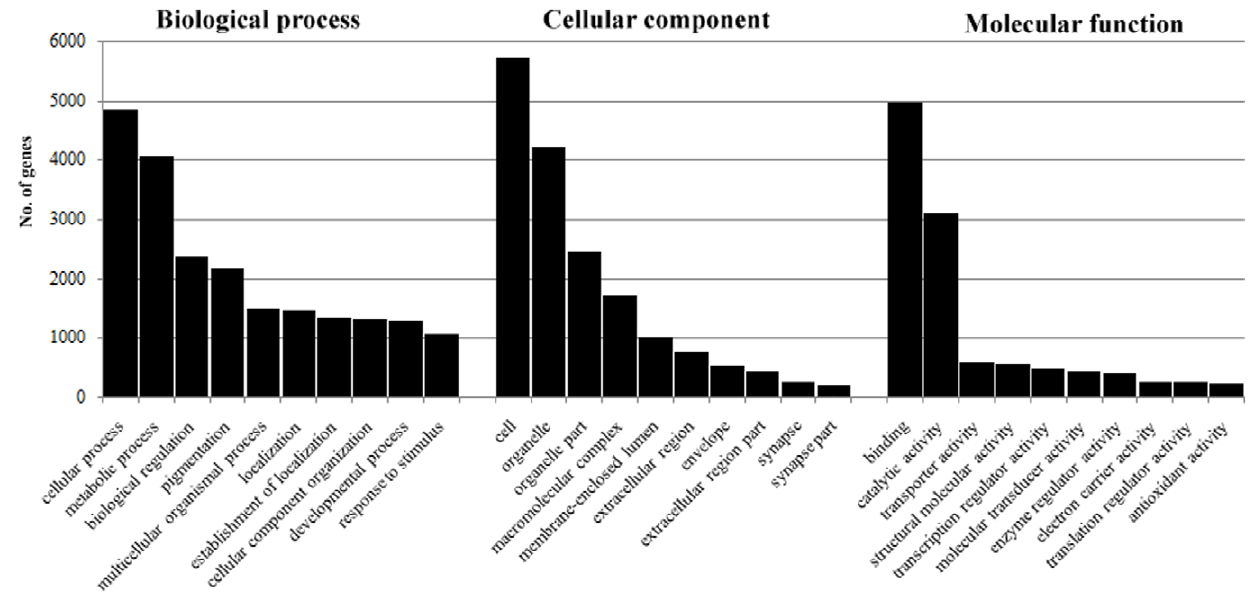
Figure 4. Gene ontology (GO) annotation of the H.diversicolor larval transcriptome. The top 10 gene ontology (GO) categories under Biological process, Cellular component and Molecular function for the early developmental transcriptomes of H. diversicolor.